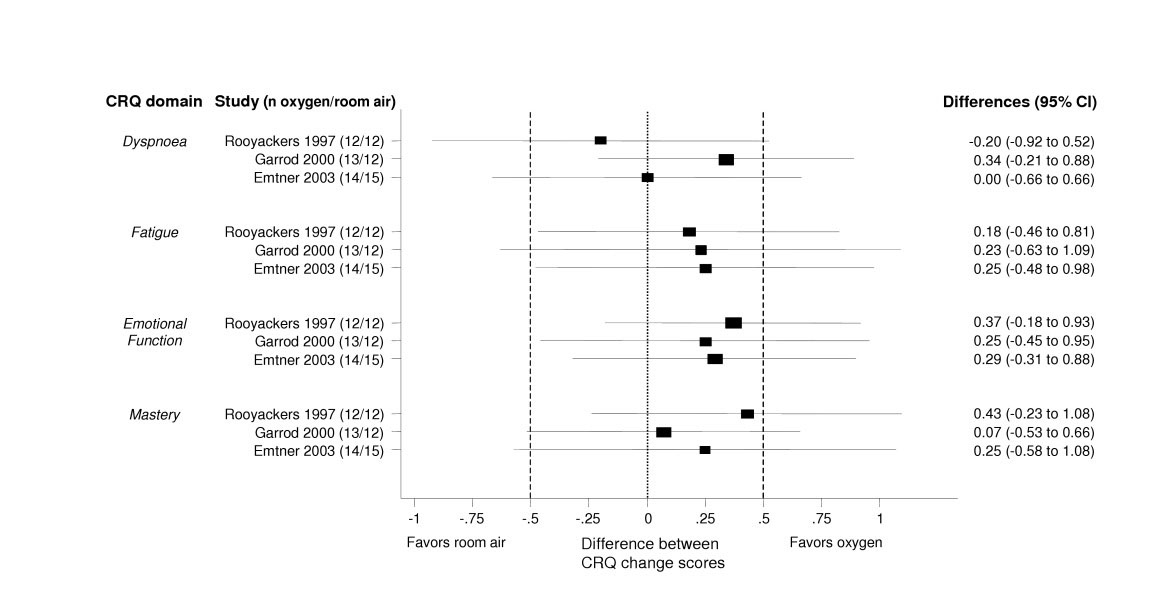
Effect of supplemental oxygen on health-related quality of life. The forest plot shows the results from three trials comparing physical exercise with and without oxygen, separately for each domains of the Chronic Respiratory Questionnaire (CRQ). The x-axis represents the difference in change scores between study groups with negative values favoring exercise on room air and positive values favoring exercise with supplemental oxygen. A difference of 0 means that both study groups changed to the same amount. Boxes with 95% confidence intervals represent point estimates for the difference between the CRQ change scores (from baseline to follow-up) of the study groups. Dotted lines represent the minimal important difference of the CRQ (change of 0.5). On the right of the forest plot, point estimates for differences between groups and 95% confidence intervals are shown.